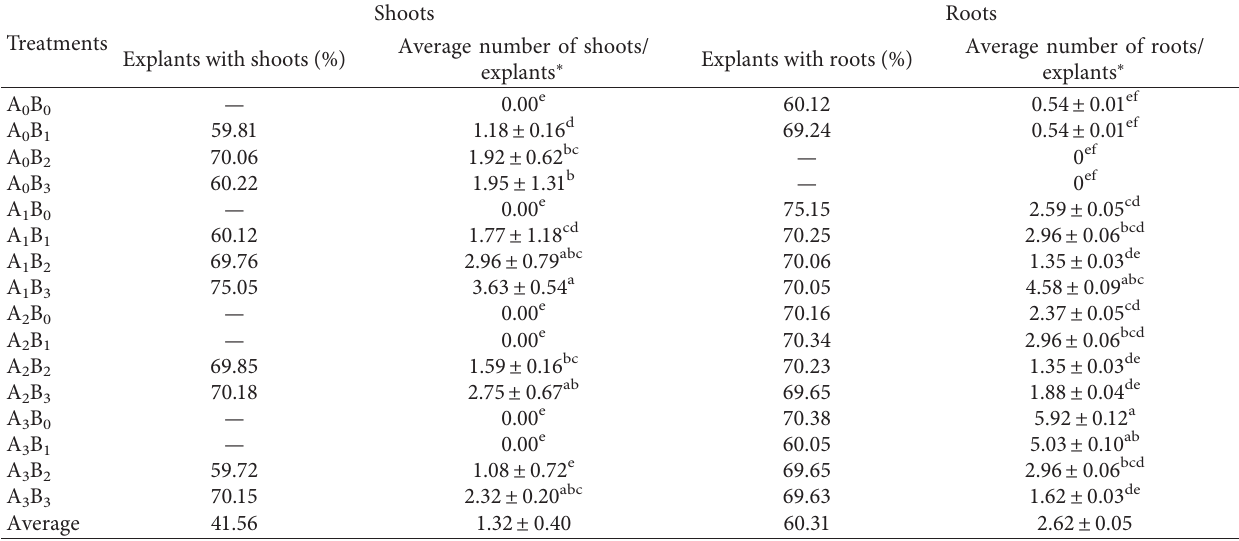
Table 5: Regeneration of shoots and roots in Styrax benzoin Dryander calli obtained from young leaves after 12 weeks of culture. Shoots Treatments